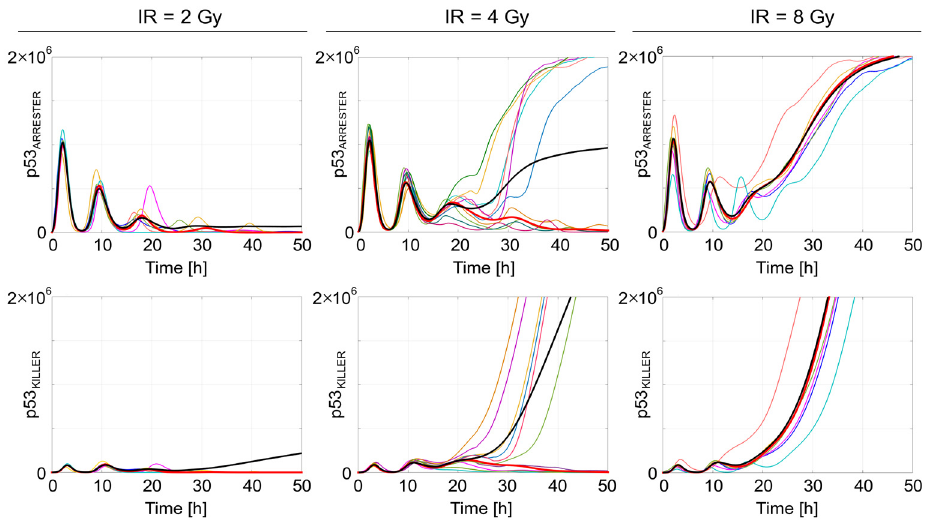
Fig 9. Stochastic vs. deterministic simulation trajectories in the response to low (2 Gy), intermediate (4 Gy) and high (8 Gy) irradiation doses. Single-cell stochastic trajectories — thin color lines; average over 1000 stochastic trajectories — bold black line; deterministic approximation — bold red line.